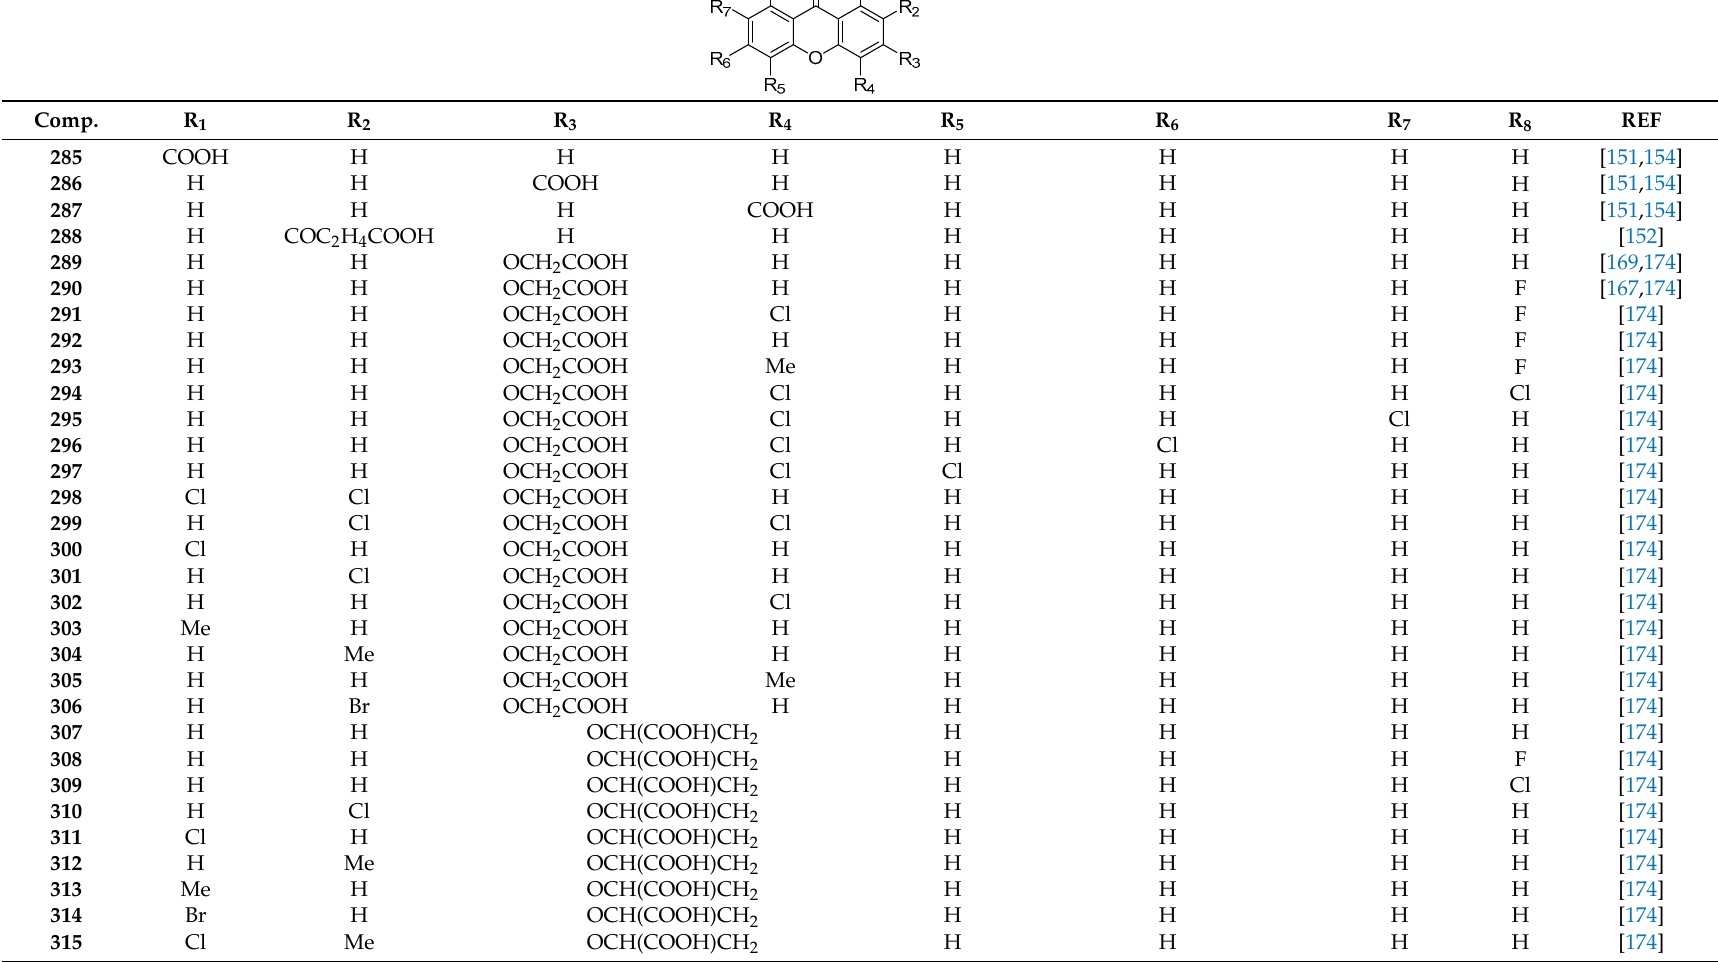
Table 2. Structures of other 9-oxo-9 H -xanthene carboxylic acid derivatives ( 285 – 338 ).